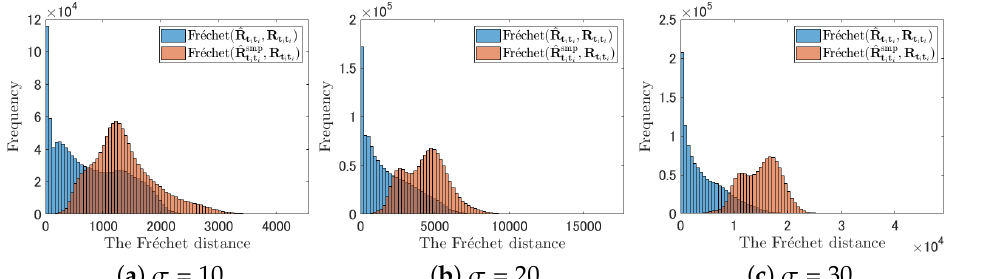
Figure 8. Histogram of two Fréchet distances: one calculated between the proposed estimated texture covariance matrix and the oracle sampled texture covariance matrix and the other calculated between the simply sampled estimate determined from the observation and the same oracle covariance